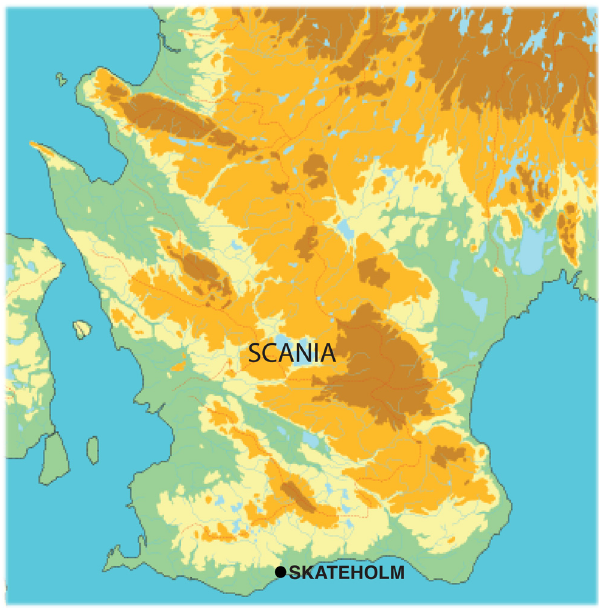
Figure 1: Location of Skateholm in the province of Scania in southern Sweden. The dark brown color - marked areas with exposed, older bedrock in